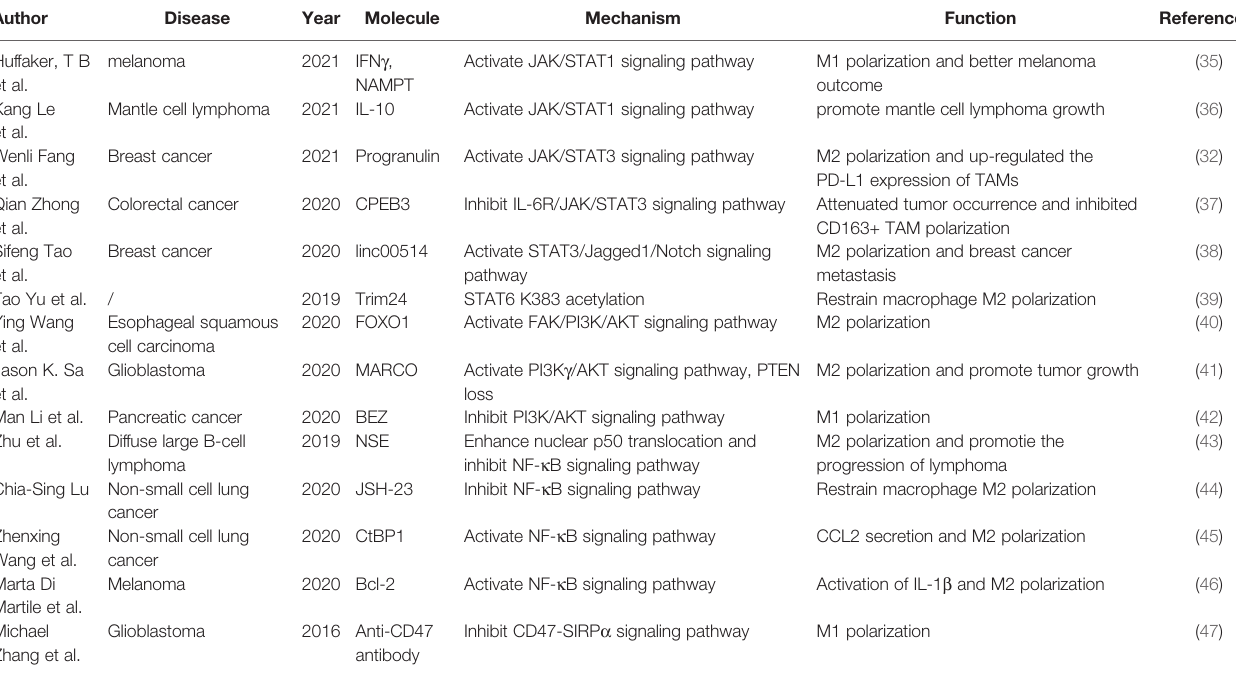
TABLE 1 | Overview of several signaling pathways associated with the repolarization of tumor-associated